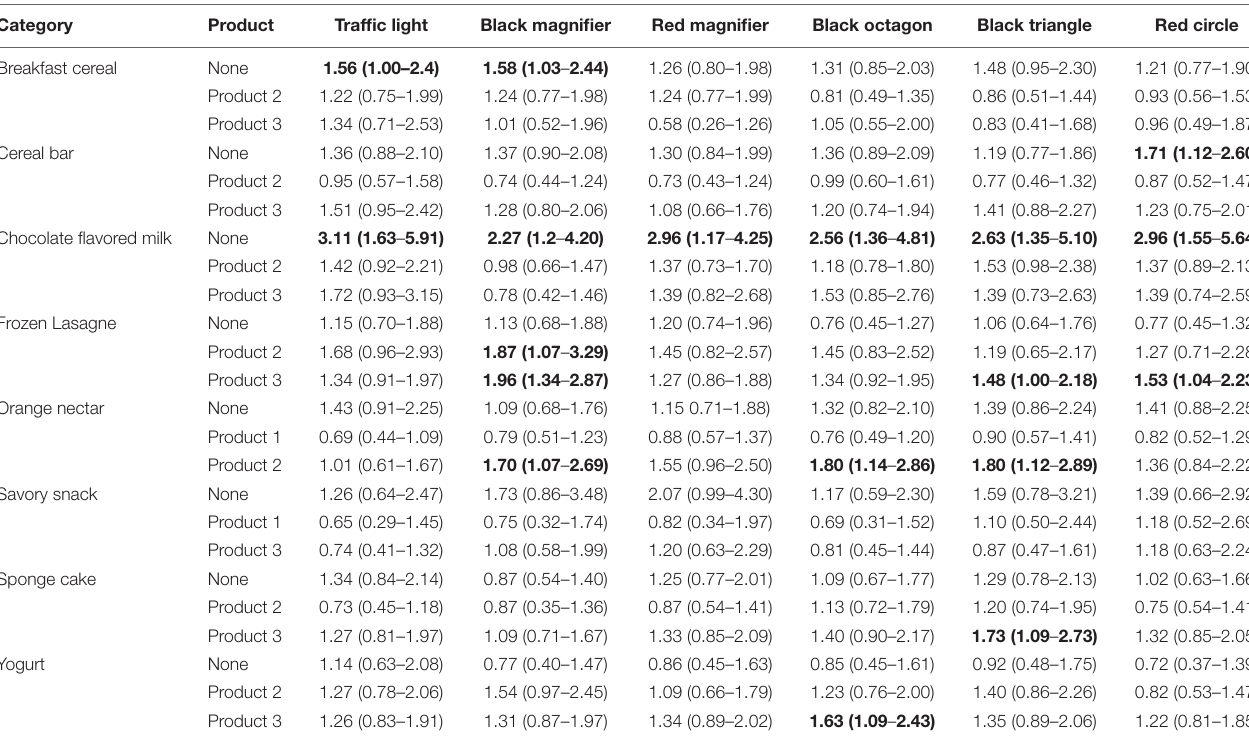
TABLE 4 | Results of the multinomial logistic regression model exploring the effect of front-of-pack nutrition labeling schemes on participants’ likelihood of selecting different products for each of the categories compared to the GDA and the least healthful products, expressed as odd ratios with their corresponding 95% confidence interval (between